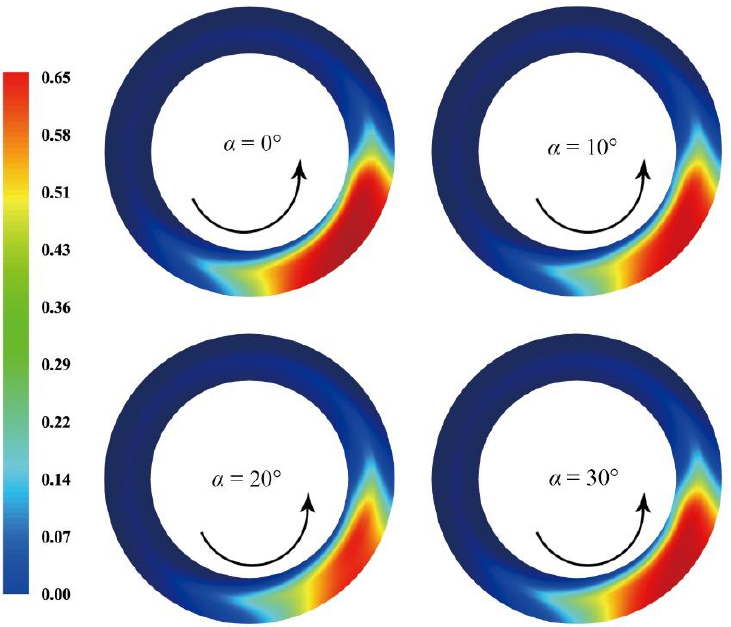
Figure 13. Annular cuttings concentration contour at different helix angle conditions.